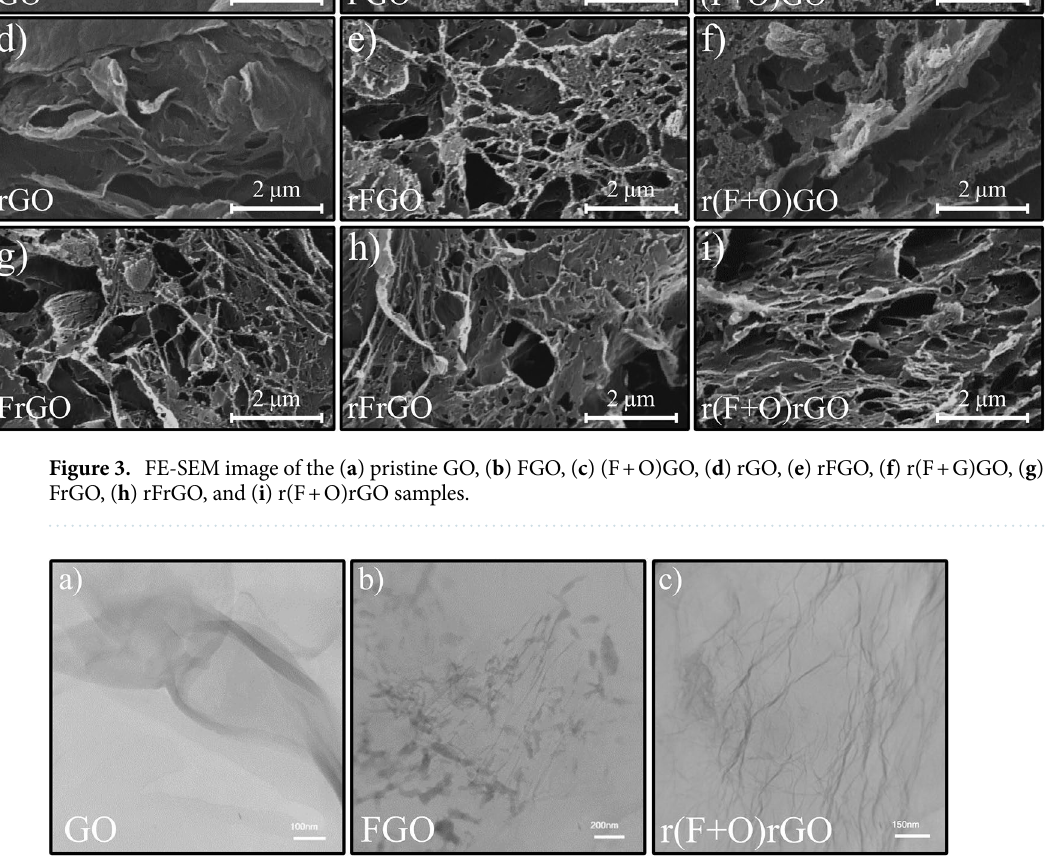
Figure 4. TEM image of the ( a ) pristine GO layer, and ( b ) FGO layer, and ( c ) r(F + O)rGO